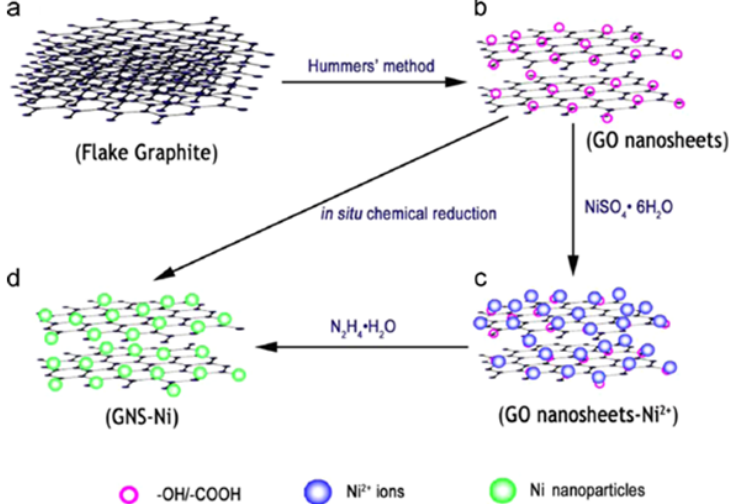
Figure 5: A schematic diagram of the in-situ chemical reduction steps for the fabrication of Ni-decorated GNS. Reproduced from Reference [113].